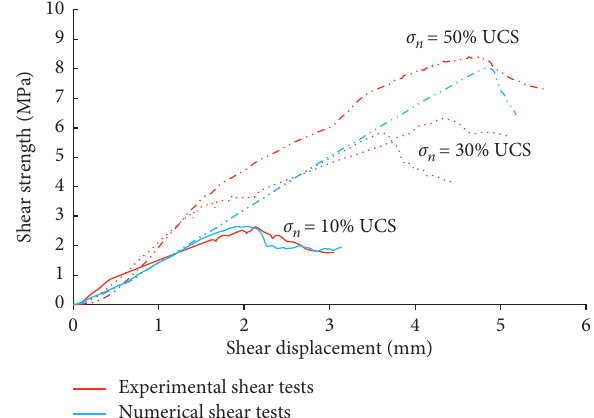
Figure 5: Experimental and numerical shear test results under CNL condition with three different normal